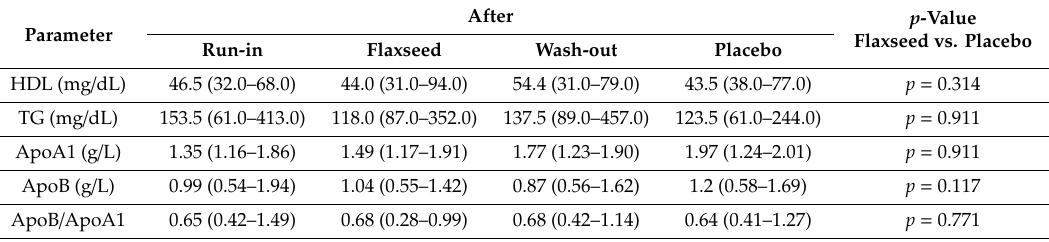
Table 4. Changes in lipids parameters throughout the study. The data are given as medians and range, n =